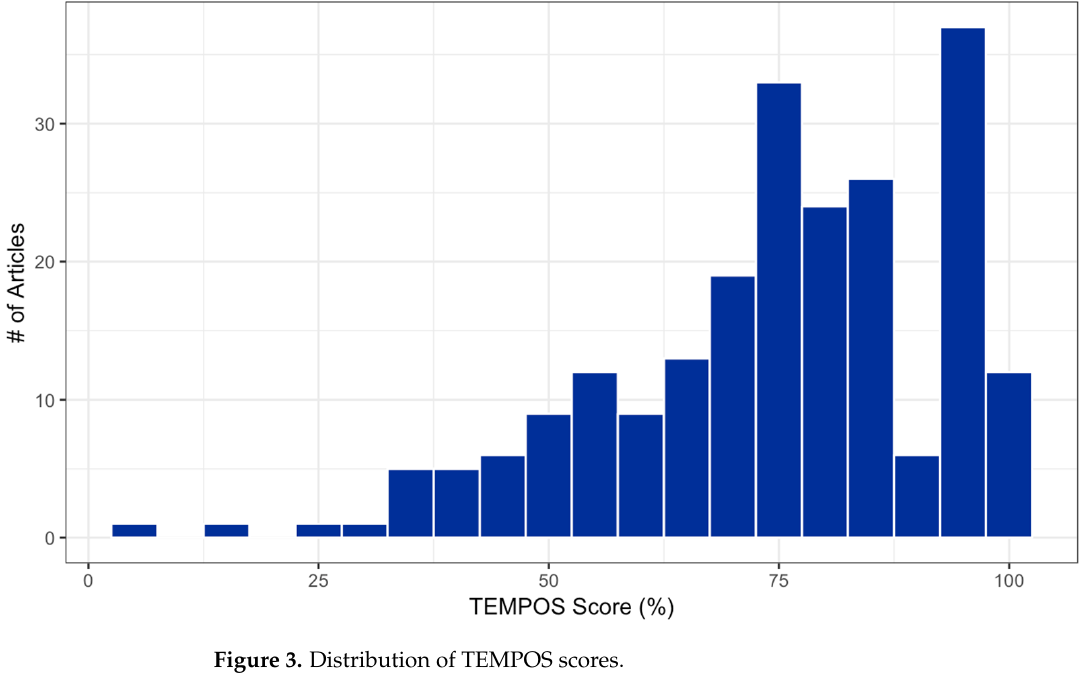
Figure 3. Distribution of TEMPOS scores.